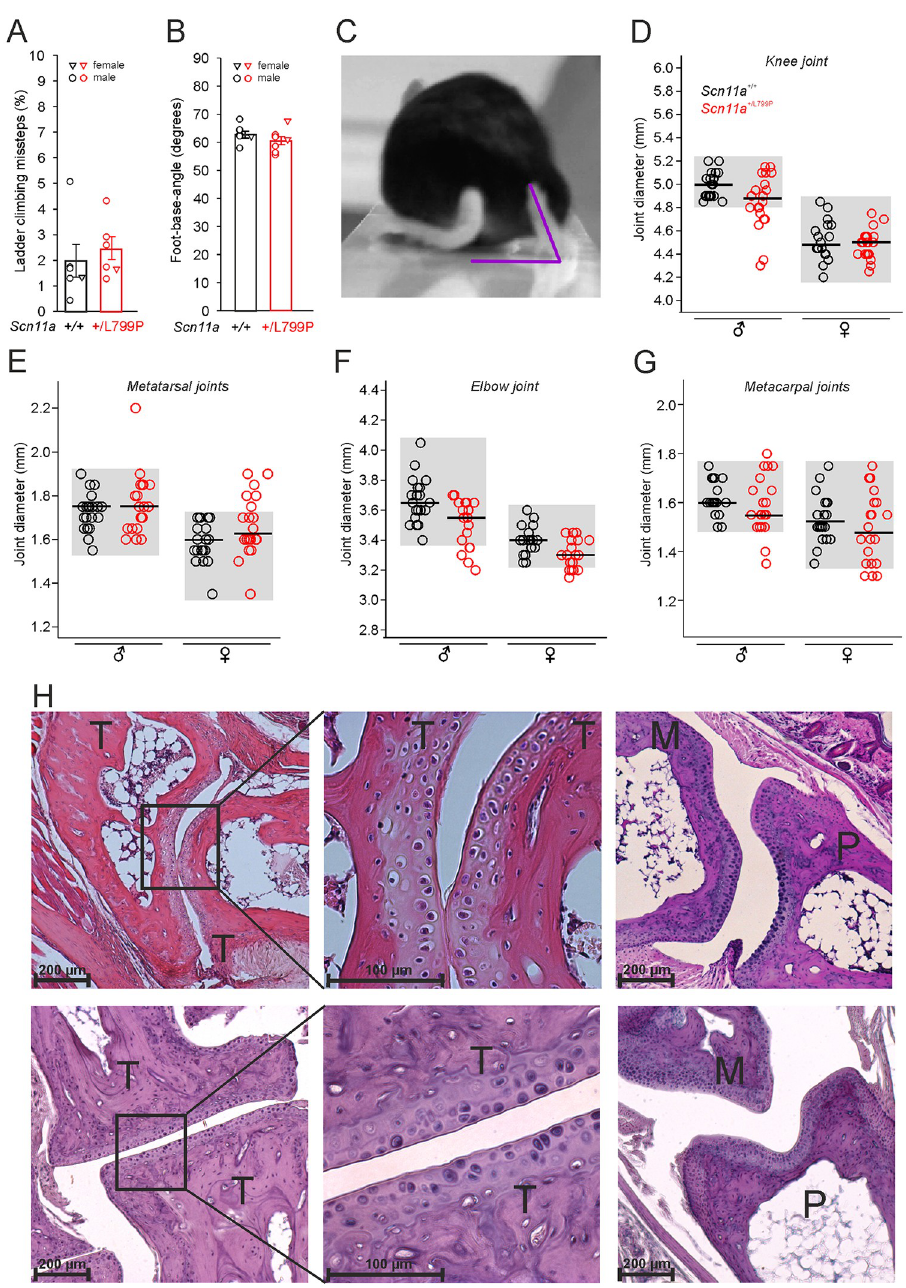
Fig 5. Quantitative gait analysis and joint diameters. No differences in the percentage of ladder climbing missteps (A) and in the foot-base-angle (B) were observed between Scn11a +/L799P mice and Scn11a +/+ mice (9–10 months, n = 6–8 per group, values are mean ± SEM). Triangles indicate values of individual female mice, cicles indicate values of individual male mice. (C) Representative single frame of a video sequence for visualization of the foot-base-angle (in purple) at toe-off position. Diameters of knee joints (D), metatarsal joints (E), elbow joints (F) and metacarpal joints (G) were compared between both genotypes (sex-matched, 2–6 months, n = 20 per genotype). Horizontal bars indicate the median of each group and grey boxes indicate the range of values from Scn11a +/+ mice for each comparison. (H) Histology after H&E staining of the paws from Scn11a +/L799P mice with enhanced metatarsal joint diameters (upper panel) and representative images from Scn11a +/+ mice (lower panel). The left microphotographs show metatarsal joints, the middle microphotographs display magnifications of the areas indicated on the left, the right microphotographs show metatarsophalangeal joints. Scn11a +/L799P mice with enhanced metatarsal joint diameters did not show pathological alterations. ♂ male, ♀ female, M metatarsal bone, T tarsal bone, P first phalanges.